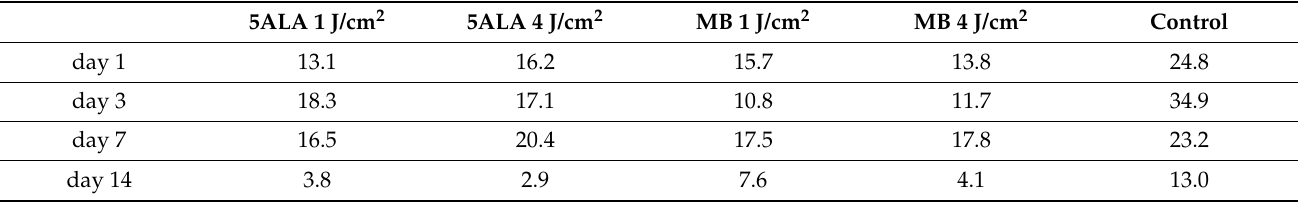
Figure 13. Difference between the wound Raman spectra of all groups subtracting the healthy skin mean Raman spectrum in the 1200–1750 cm − 1 spectral range. The Raman spectra are presented in terms of mean ± StD values. Black line—5ALA 1 J/cm 2 , black dashed line—5ALA 4 J/cm 2 , red line—MB 1 J/cm 2 , red dashed line—MB 4 J/cm 2 , blue line—control, green line—healthy skin (the number of processed Raman spectra was equal to 30 for each group). Table 3. Mahalanobis distances in the PC2–PC3 space between the healthy skin and other groups in the 2800–3000 cm − 1 spectral range on various observation